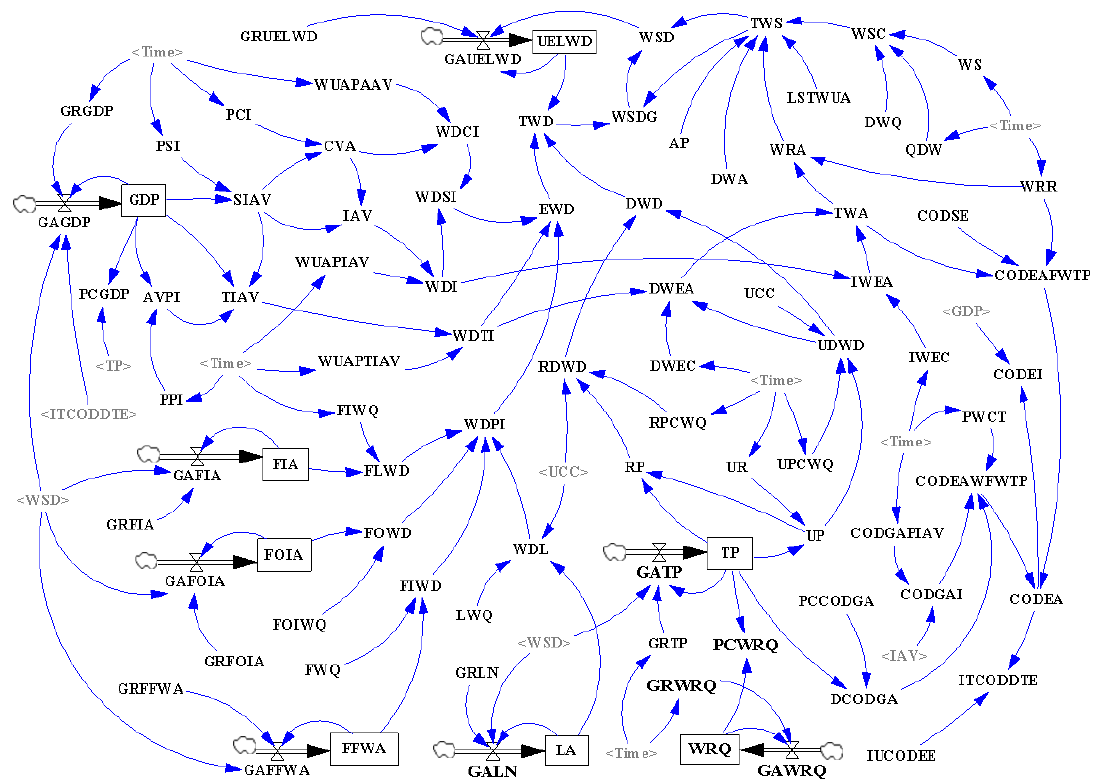
Figure 3. The flow graph of the water resource